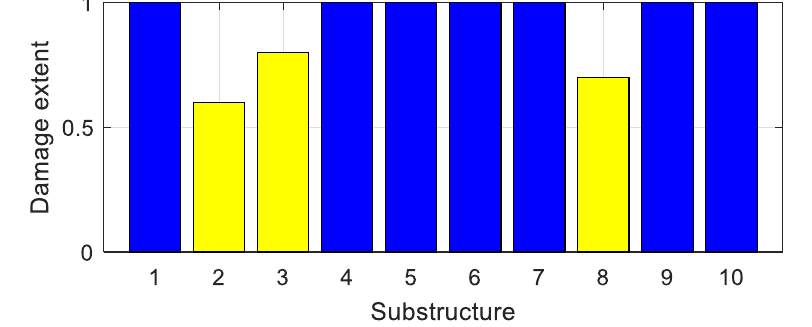
Figure 16 . Damage extents of the substructures. Figure 16. Damage extents of the substructures. Table 3. First four natural frequencies (Hz).